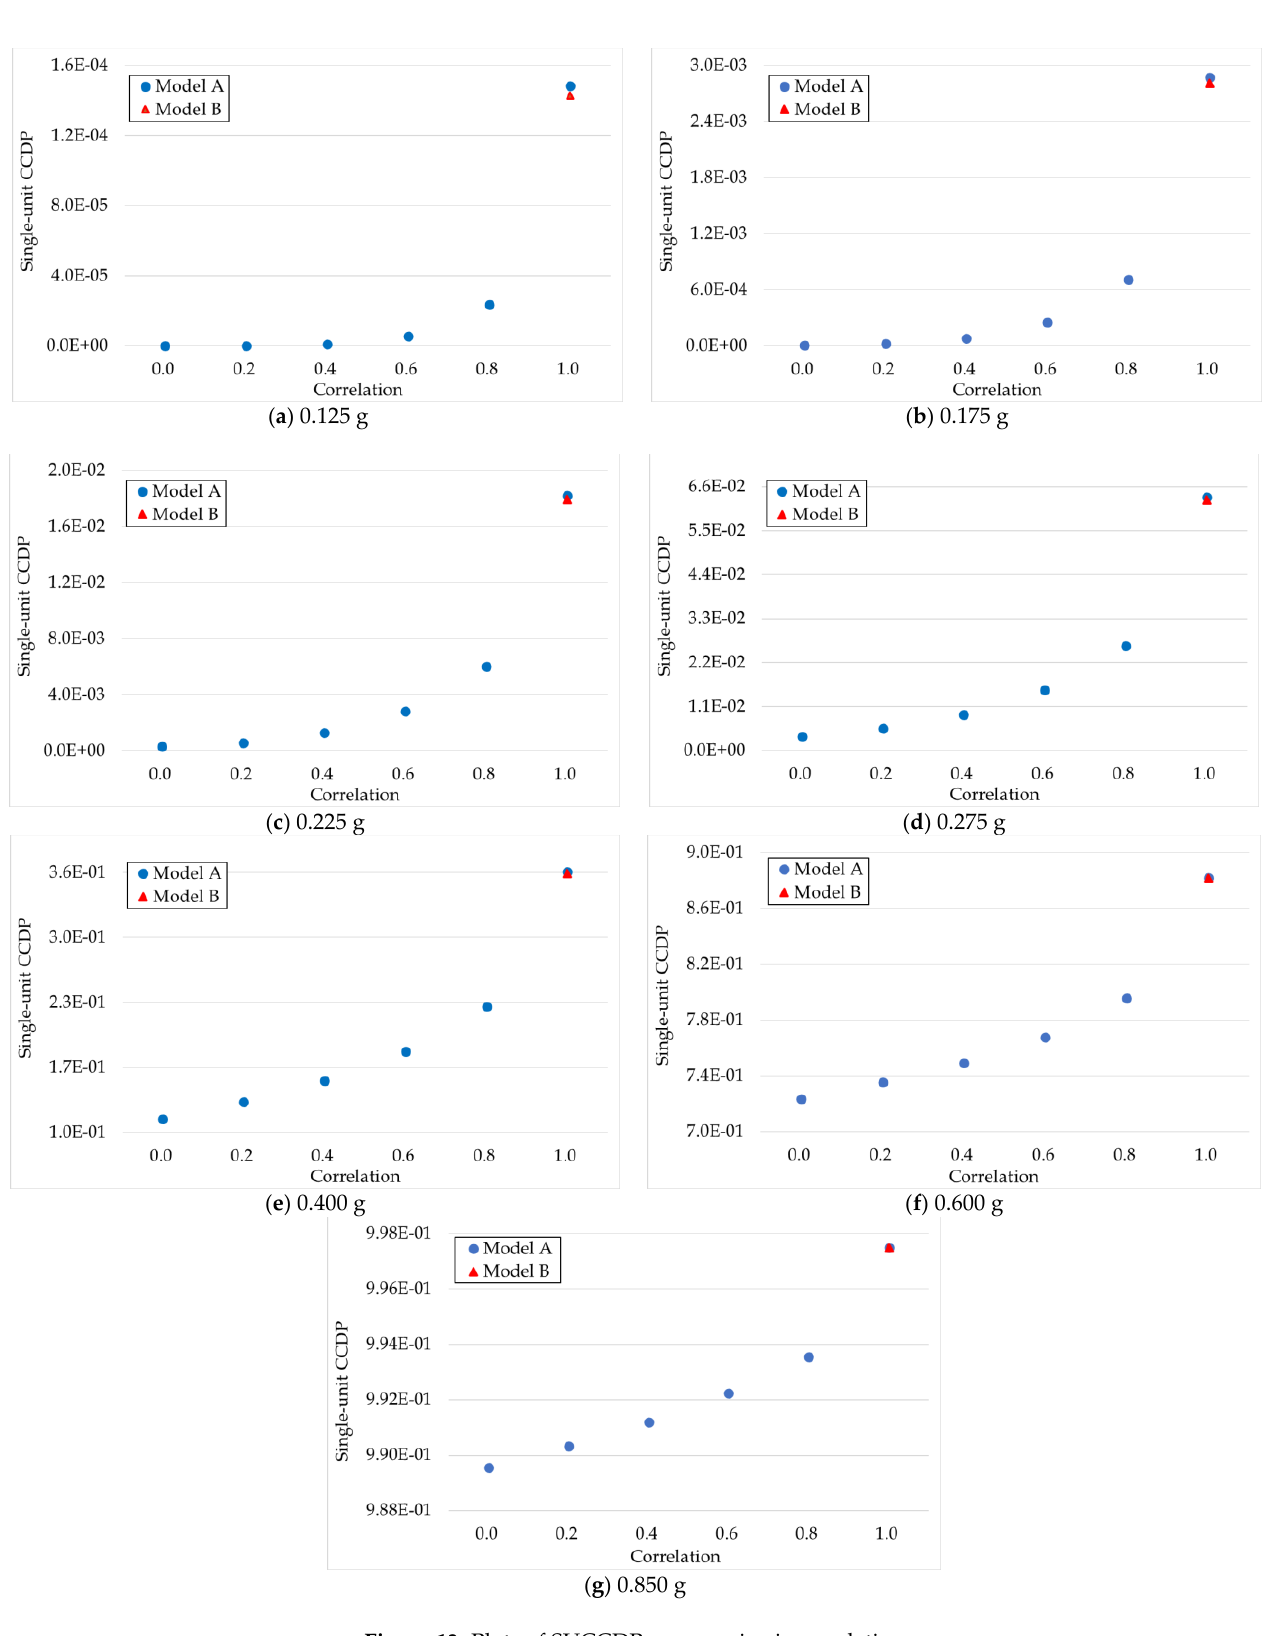
Figure 13. Plots of SUCCDP versus seismic correlation.